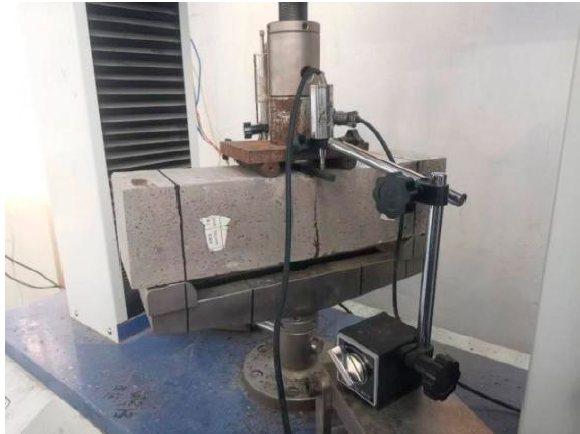
Figure 1. Loading diagram of cube compressive test.